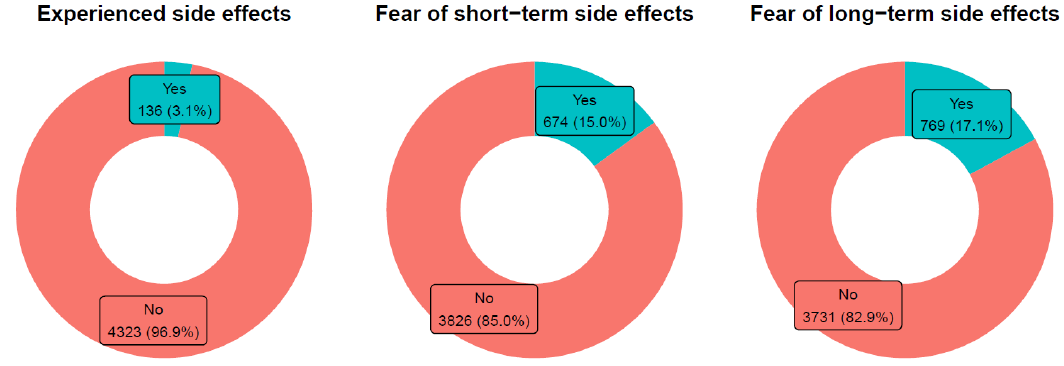
Figure 3. Frequencies of participants with experienced or feared side effects.